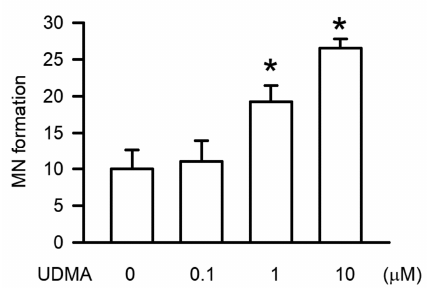
Figure 3. UDMA induced micronucleus (MN) formation in RAW264.7 macrophages. Data are expressed as mean ± SD (n = 5). *p < 0.05 is considered significant compared with the control group.